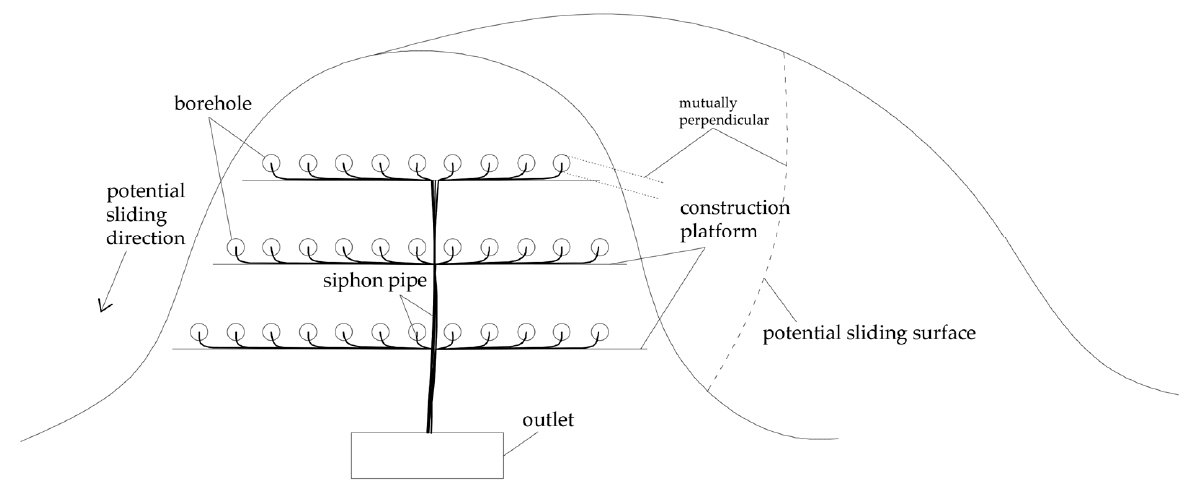
Figure 2. Schematic diagram of the inclined pipe siphon drainage method with long horizontal pipe sections (front view).